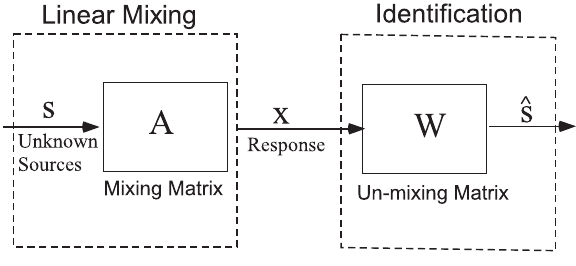
Fig. 1. Basic framework of blind source